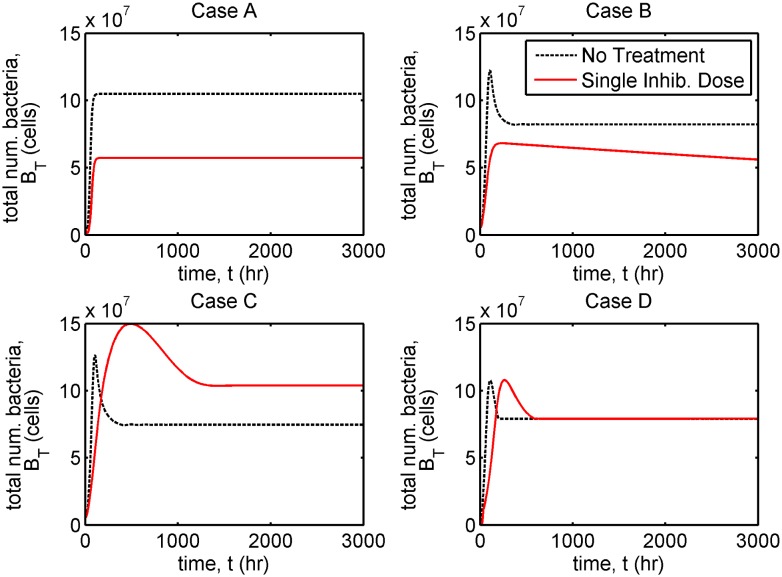
Comparison of bacterial population dynamics in the untreated and single inhibitor dose scenarios.The total number of bacteria, BT(t) (= VBF(t) + ArBB(t)), is plotted in each case. Simulations extend beyond the time span of the experiments, to 3000 hours = 125 days. Case A: the bacterial population size is an essentially monotone increasing function of time in both untreated and treated scenarios, reaching an early steady-state at which the bacterial population size with treatment is roughly half that without; Case B: the bacterial population size with treatment remains below that without treatment, decreasing gradually after reaching an early maximum; Case C: treatment results in a sustained and significant increase in the bacterial population size, Case D: treatment causes the bacterial population size to temporarily exceed that without treatment, settling to a steady-state close to that of the untreated scenario. Eqs 1–8 were solved using ode15s. See Tables 1 and 2 for parameter values.